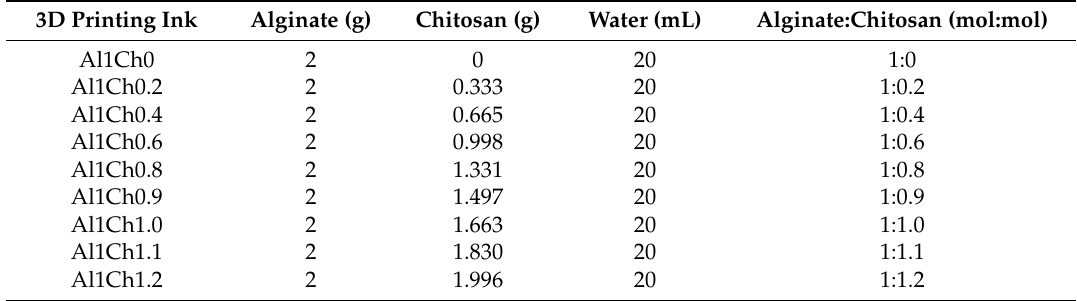
Table 1. Three-dimensional (3D) printing ink made from different molar ratio of alginate to chitosan.